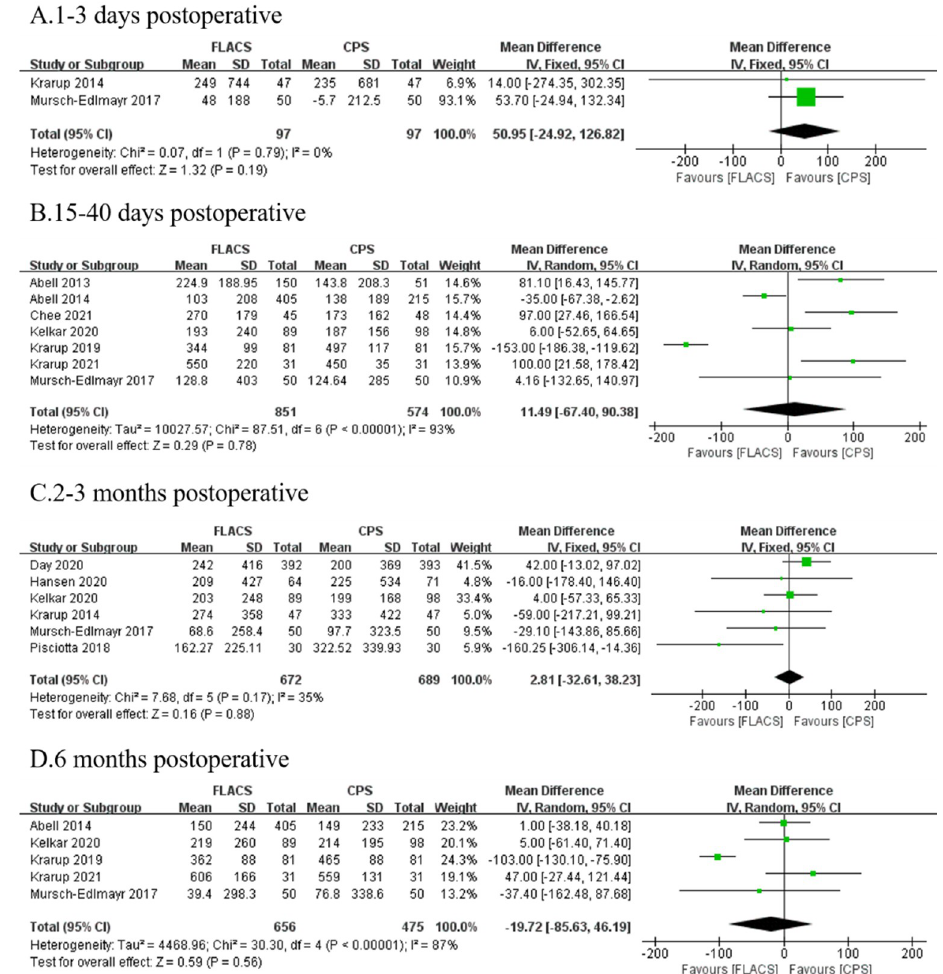
Fig 4. Forest plot of postoperative ECL between FLACS and CPS at A. 1–3 days, B. 15–40 days, C. 2–3 months, and D. 6 months.